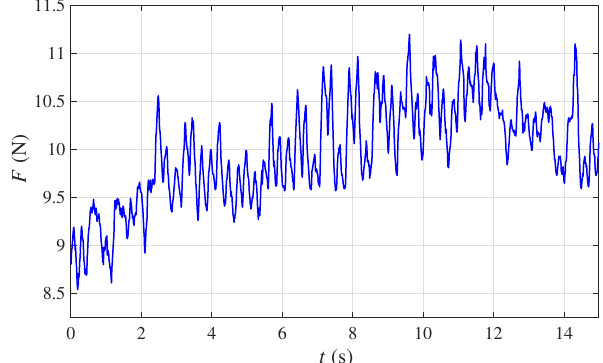
Figure 8. Stress data of volunteer